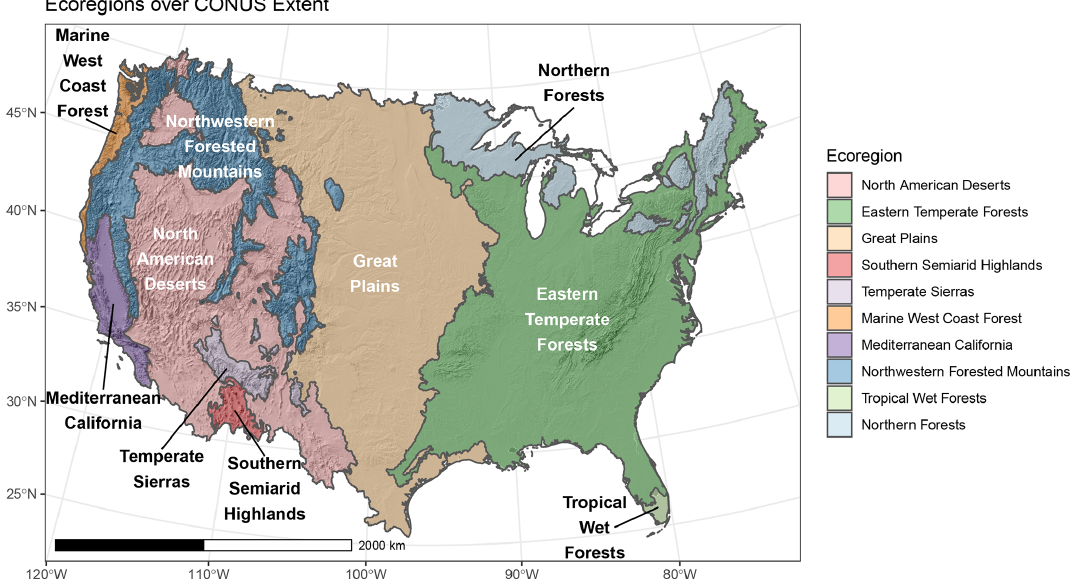
Figure 1. Distribution of the 10 ecoregions covering the CONUS study